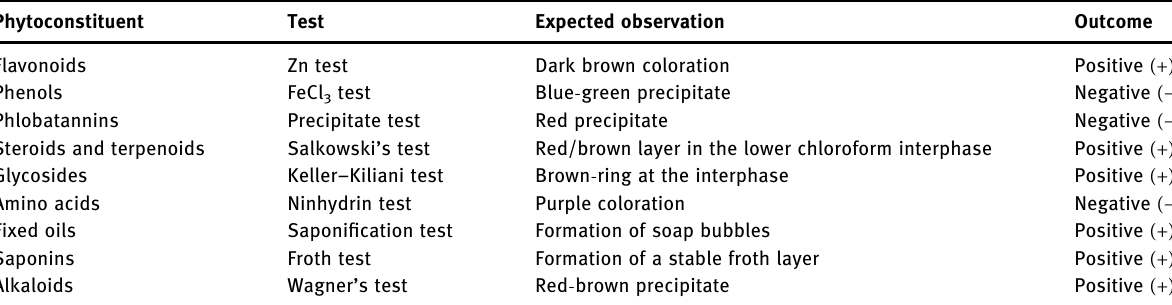
Table 3: Qualitative plant - based phytochemical screening test results for SMEAF Phytoconstituent